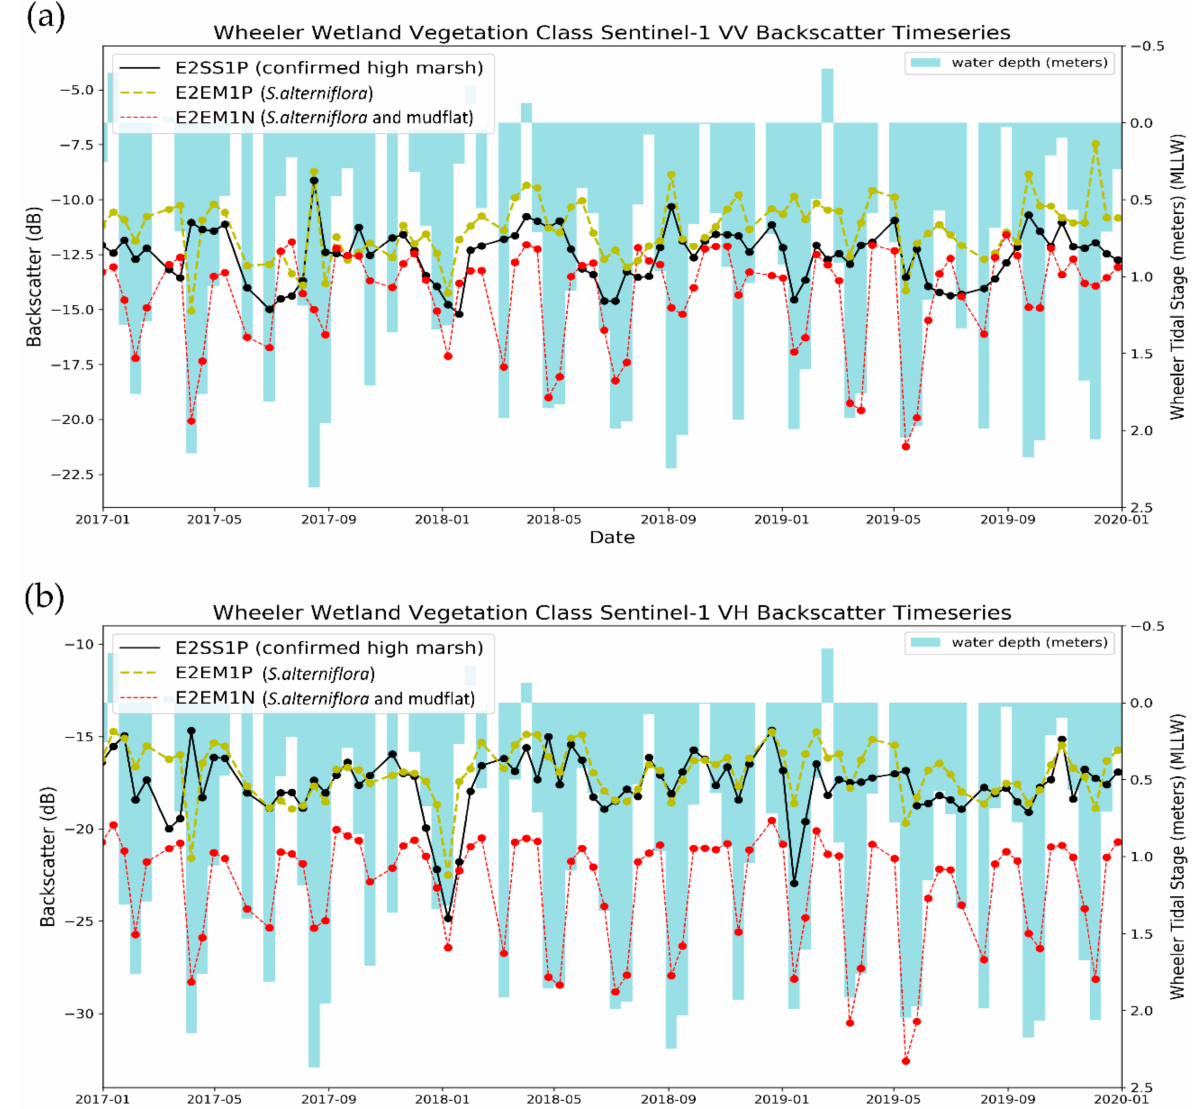
Figure 6. Wheeler wetland vegetation class Sentinel-1 VV and VH polarized backscatter time-series from 2017–2019 in (panels ( a ) and ( b ), respectively). Dates are shown in numeric year-month format. Water depth (in meters) is the NOAA tide gauge at Bridgeport (ID: 8467150) calibrated to in-marsh water level changes observed with Onset HOBO sensors from August 2018 to December 2018. Calibrations include time and water depth adjustments. E2EM1N (red dotted series) represents a low elevation portion of the wetland complex with sparse S. alterniflora and mudflat backscatter series. E2EM1P (gold dashed series) represents middle elevation marsh with dense S. alterniflora . E2SS1P (black series) is a high marsh dominated by Spartina patens , Distichlis spicata , and short-form S. alterniflora . For both E2EM1P and E2SS1P, some P. australis is present along wetland–open water and wetland–upland